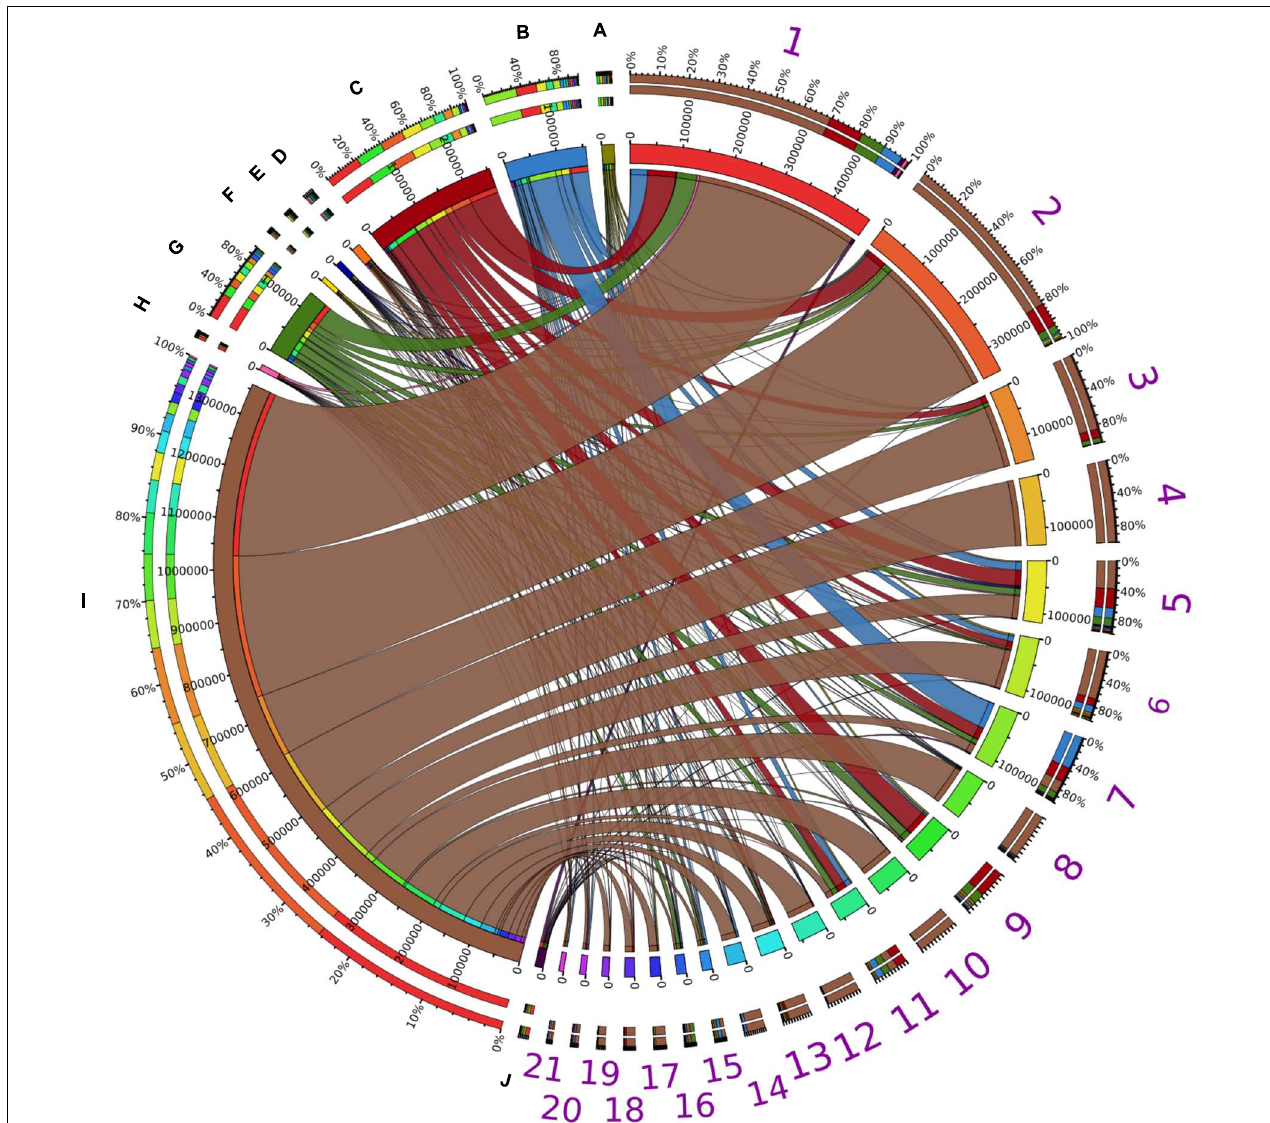
FIGURE 4 | Taxonomic distribution of assigned PLPs. Taxonomic distributions of assigned PLPs in abundant bacterial phyla possessing PLP-encoding genes across all the samples. The abundance inferred from LPGM values matrix of assigned PLPs per family identified in each bacterial phylum was generated by summing the corresponding LPGM values across all samples. The width of each seperated sector from each bacterial phylum (A-J) and lipolytic family (1–21) indicates their relative abundances across all samples. The corresponding colors were shown in the third ring (from outside in). In the outermost ring, sectors A–J indicate the distribution of lipolytic families in each bacterial phylum. This is also the case for bacterial phyla in each lipplytic family of sectors 1–21. A, Acidobacteria ; B, Actinobacteria ; C, Bacteroidetes ; D, Chloroflexi ; E, Cyanobacteria ; F, Deinococcus-Thermus ; G, Firmicutes ; H, Planctomycetes ; I, Proteobacteria ; J, Verrucomicrobia ; 1, Hormone-sensitive_lipase_like; 2, patatin-like-protein; 3, A85-EsteraseD-FGH; 4, Bacterial_lip_FamI.1; 5, VIII; 6, Homoserine_transacetylase; 7, II; 8, Lipase_3; 9, A85-Feruloyl-Esterase; 10, ABHD6-Lip; 11, Carb_B_Bacteria; 12, Bacterial_lip_FamI.3; 13, Lysophospholipase_carboxylesterase;